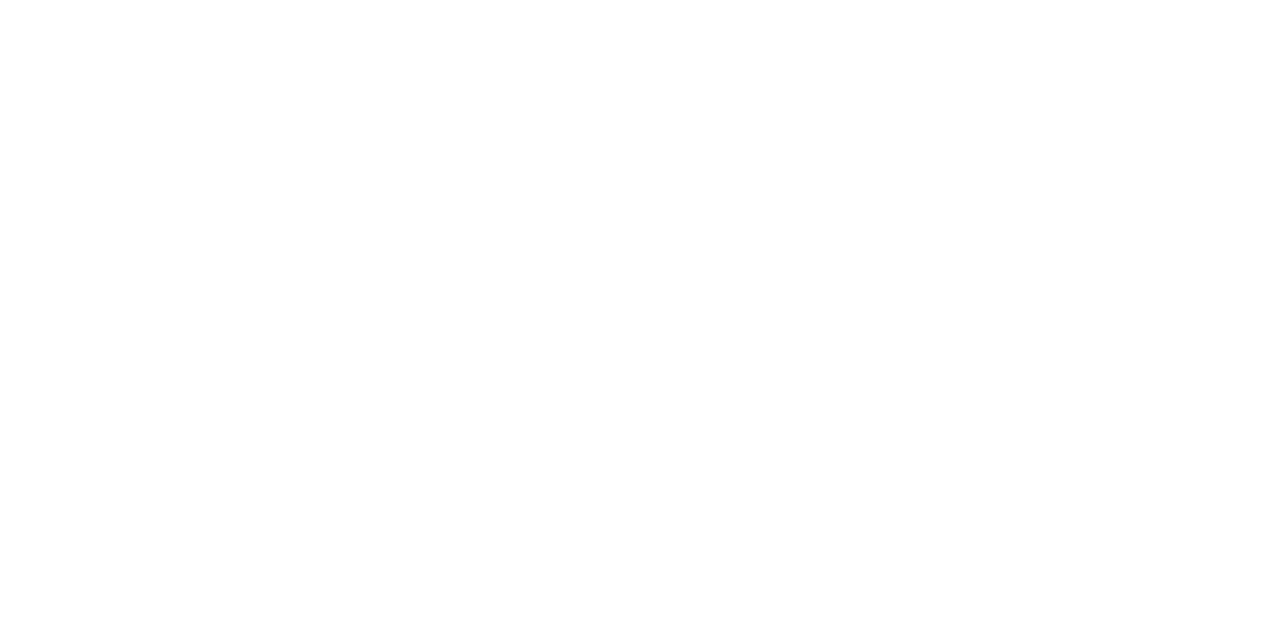
Frontiers in Genetics |